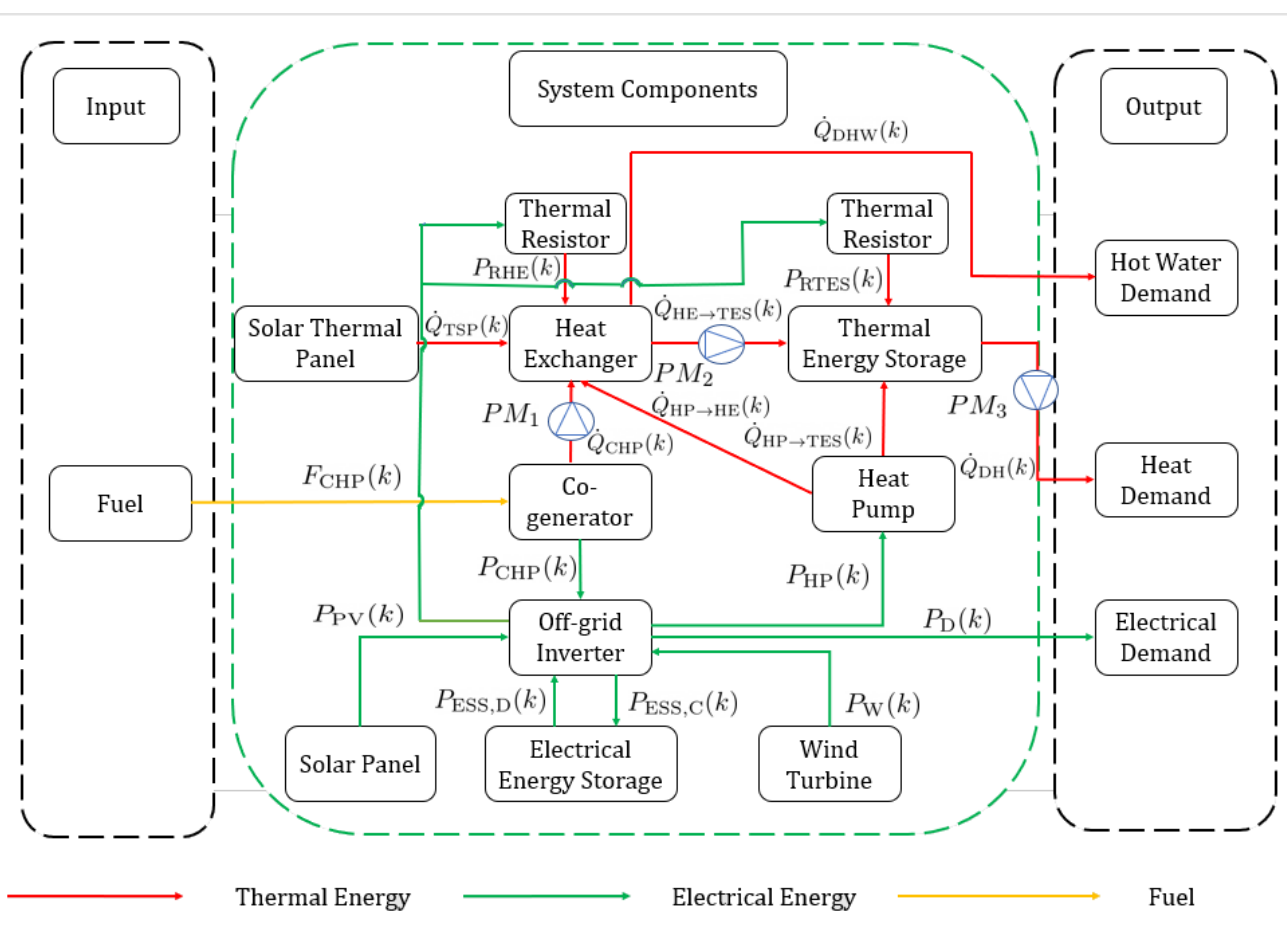
Figure 1. System Architecture. The yellow lines represent the gasoline (fuel) flows, and the green lines represent the electrical energy flows, while red lines represent the thermal energy